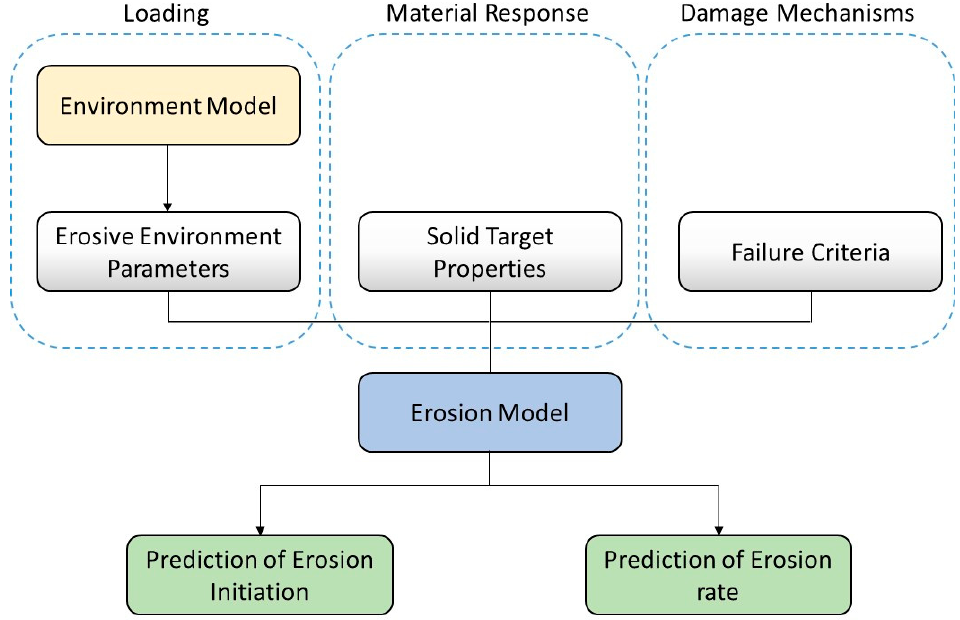
Figure 16. Formulation of a simple erosion prediction model.